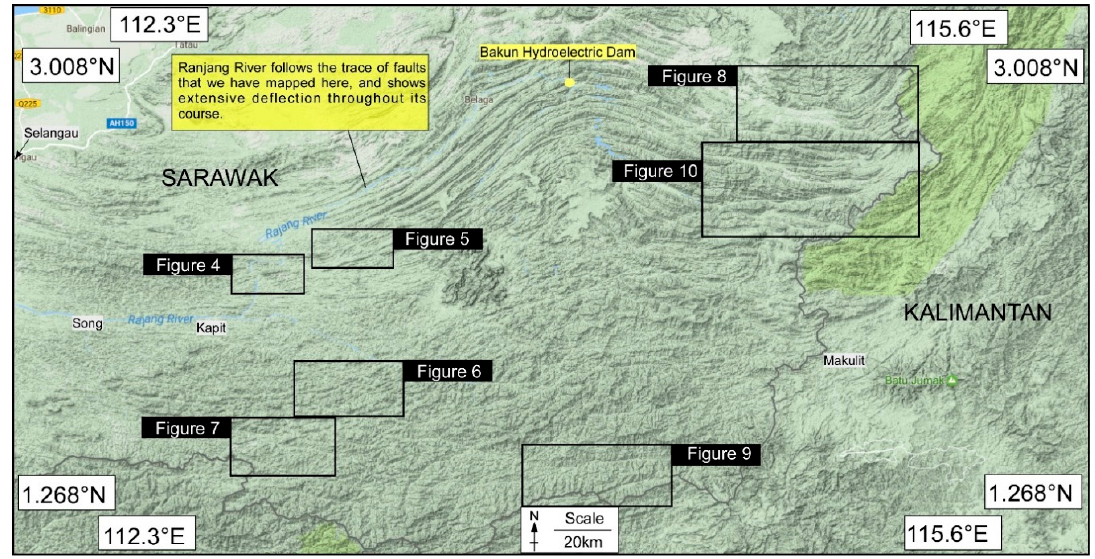
Figure 3. Google satellite terrain image shows the location of some of the selected regions in Borneo where faults have been mapped. The details are in subsequent figures.